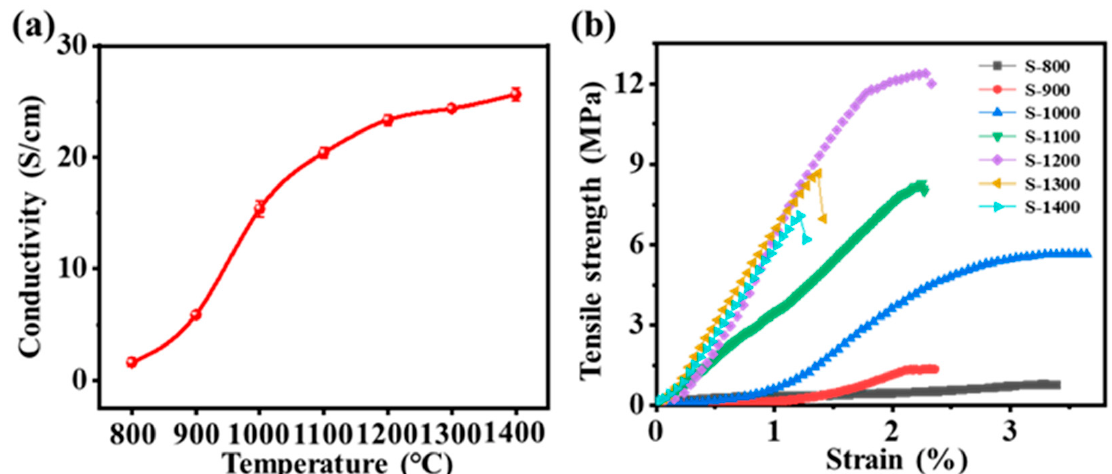
Figure 4. ( a ) Electrical conductivity and ( b ) tensile strength of electrospun TaC/C composite fabric samples at different carbonization temperatures.